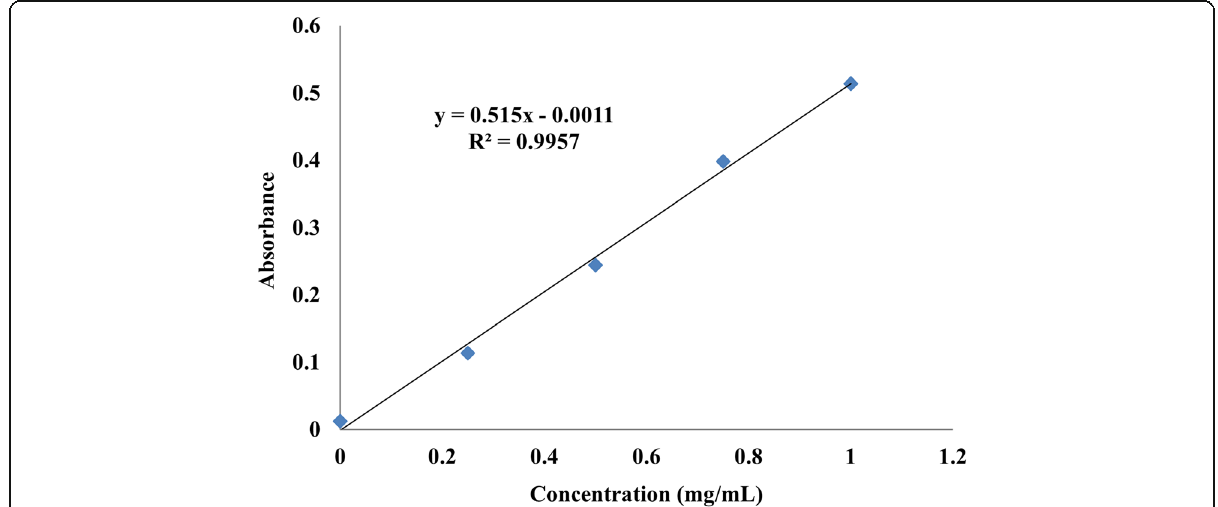
Fig. 2 Total flavonoid content determination of Merremia umbellata extract with the help of Quercetin standard calibration